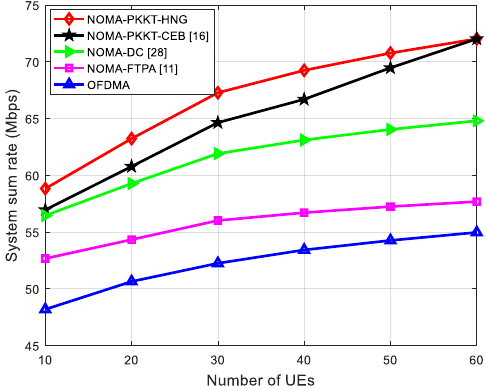
Figure 4. System sum rate vs. number of UEs per BS.